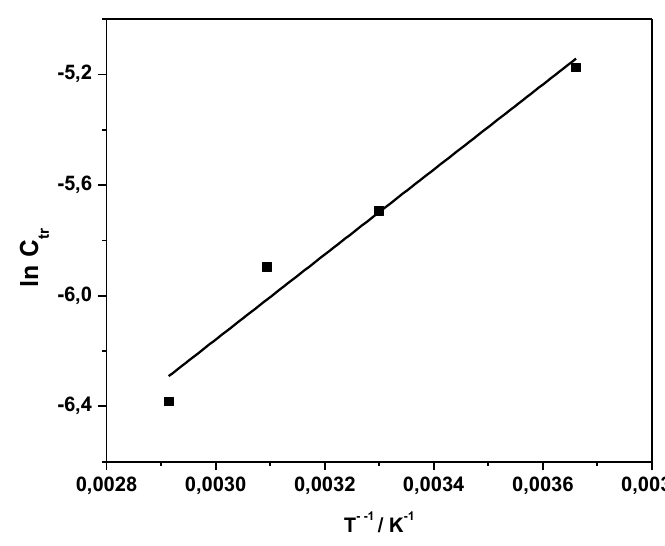
Figure 3 . Arrhenius plot of C tr obtained in the temperature range of 0–70